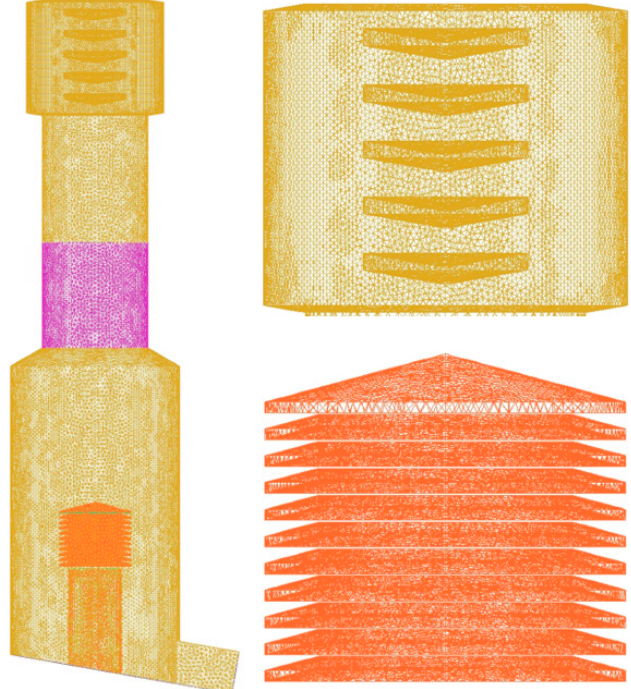
Figure 1. Mesh shape for flow calculation.